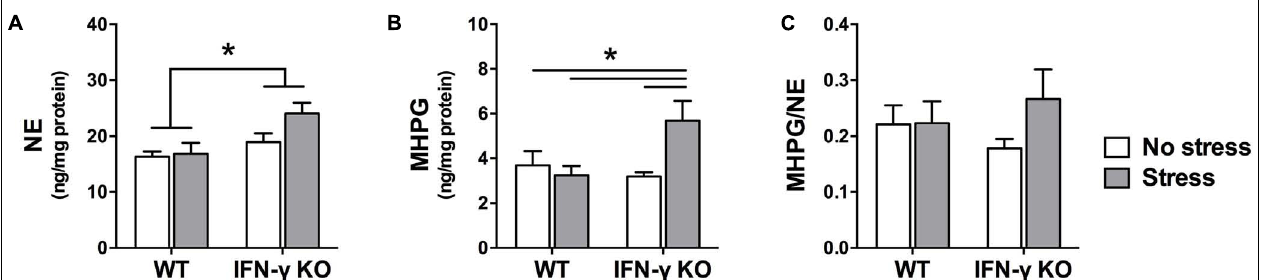
FIGURE 5 | Locus coeruleus noradrenergic activity as a function of IFN- γ knockout and chronic stressor exposure. Compared to the wild-type animals, concentrations of locus coeruleus NE (A) were significantly higher among the IFN- γ -deficient mice, regardless of stressor exposure. As regards MHPG in this brain region (B) , whereas metabolite levels were unaffected by